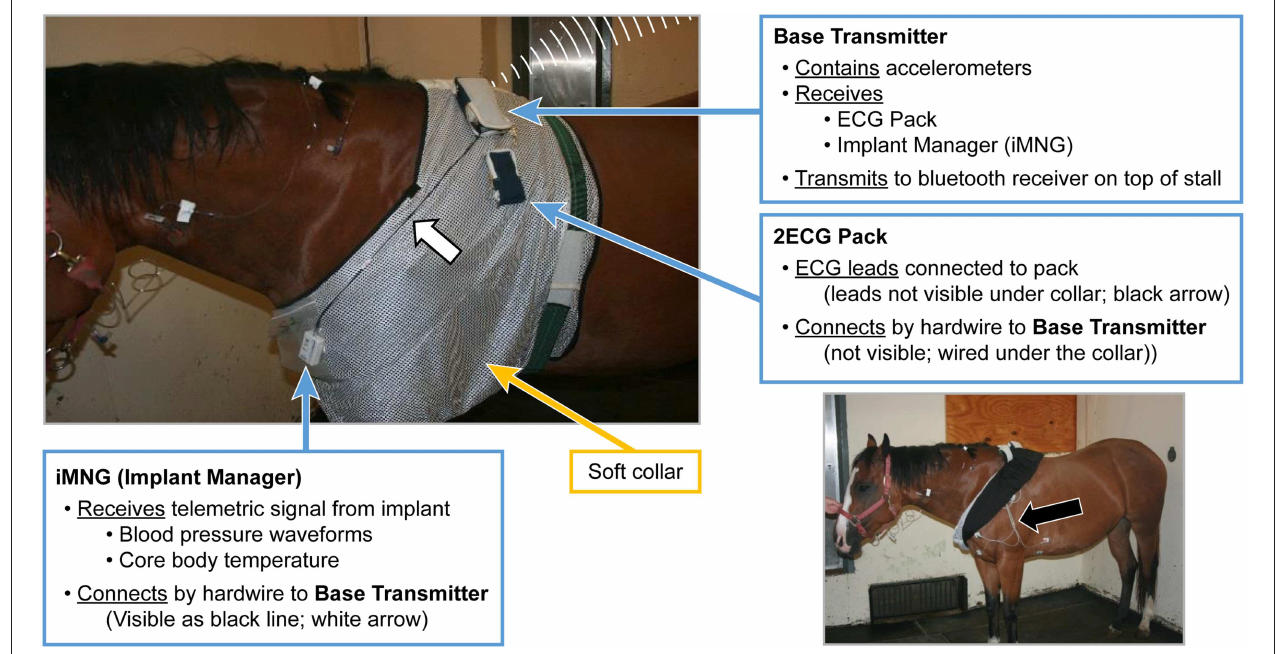
FIGURE 1 | Picture of horse with soft collar applied and the connections of iMNG (Implant Manager), and the 2ECG Pack, to the Base Transmitter. Black Arrow identifying ECG leads and electrode placement.